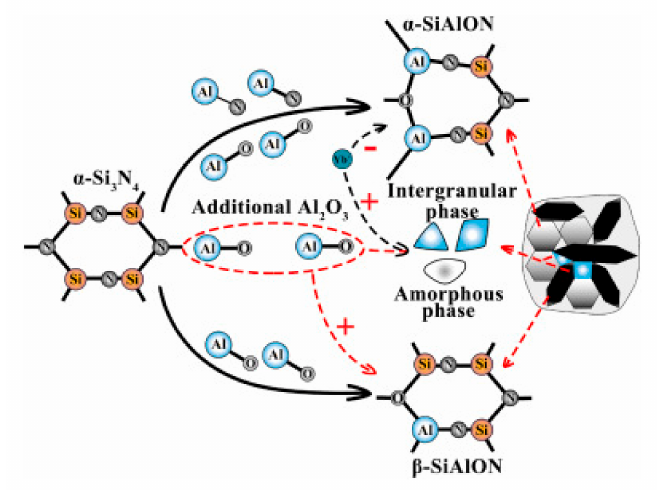
Figure 2. Schematic diagram of the effect of additional Al 2 O 3 on the phase formation, reproduced from [136], with permission of Elsevier